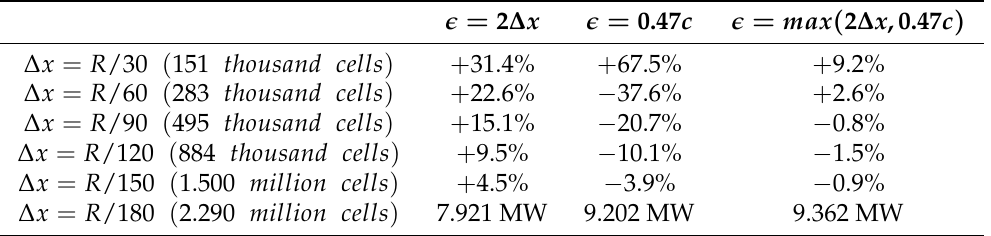
Table 1. Variation of power [MW] with increasing the structured region characteristic length ∆ x [m]. Reference power corresponds to minimum value ∆ x = R /180.